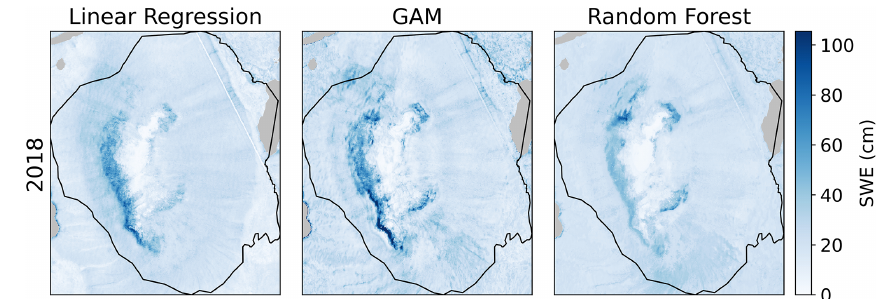
Figure A6. All three models trained on single year (2018) at Kougarok Hillslope.